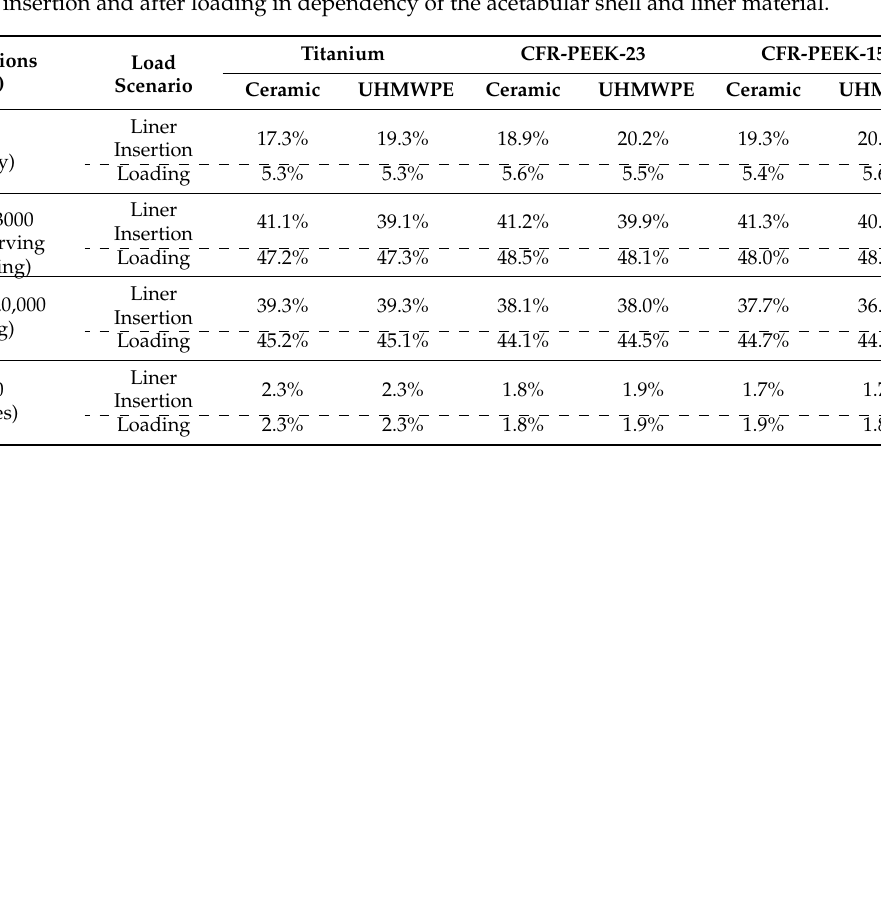
Figure 4. Strain distribution in the adjacent bone of the hemi-pelvis after relaxation of the acetabular shell, dependent on the chosen shell material ( a ) titanium, ( b ) CFR-PEEK-23 and ( c ) CFR-PEEK-15. Di ff erences visible on the macroscopic scale are highlighted in red. Table 5. Comparison of the percentage of analyzed nodes, categorized into the di ff erent strain regions after liner insertion and after loading in dependency of the acetabular shell and liner